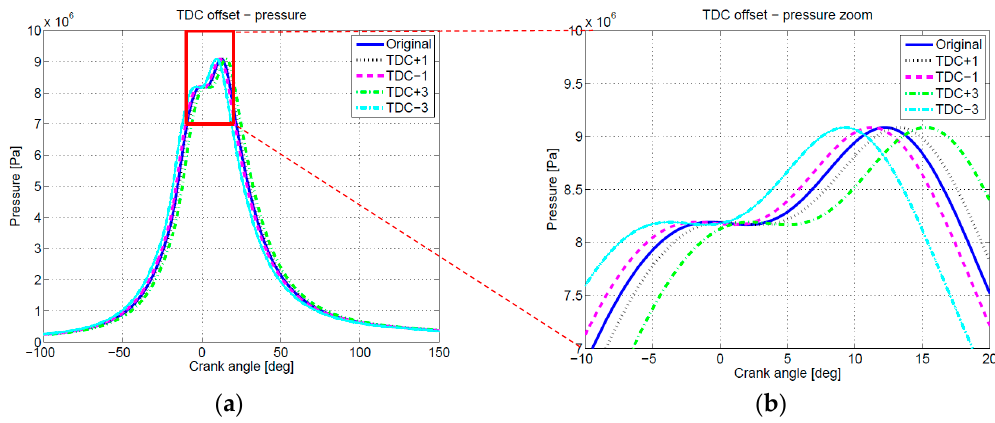
Figure 1. ( a ) TDC offset variations (±1, 3 °CA) of the pressure trace with respect to the crank angle at 2000 1/min and 100 Nm; ( b ) detailed view.